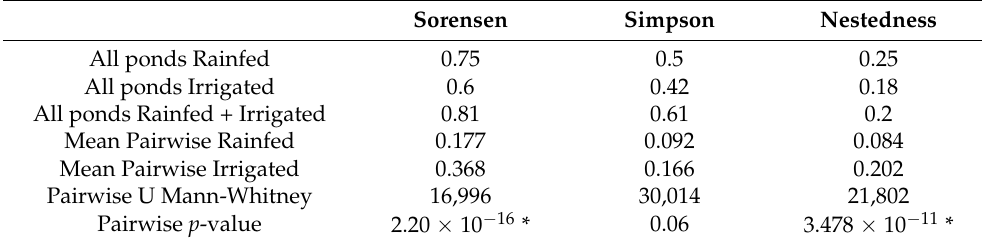
Table 1. Partition of total and pairwise beta diversity in irrigated and rainfed ponds, following the additive partition approach. The statistical significance of differences between groups was assessed with Mann–Whitney tests. * Significant under α =